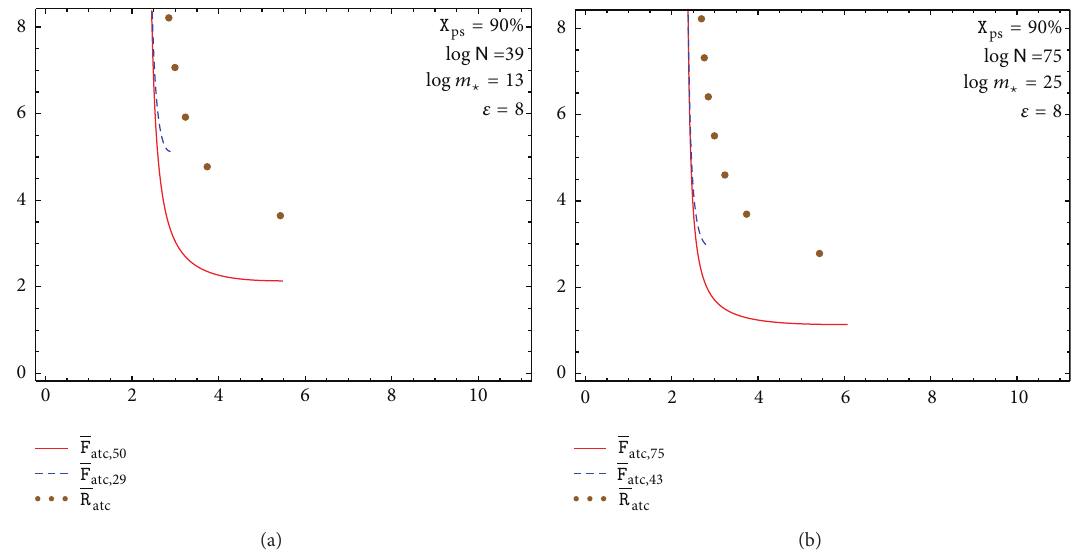
Figure 2: The adjusted tradeoff coefficient F top: F ). msc